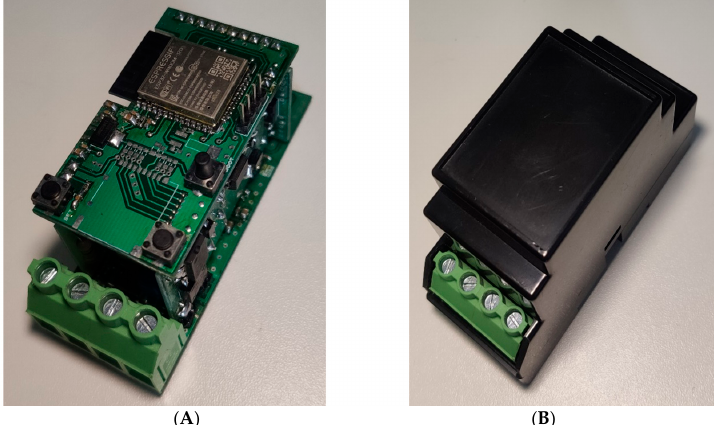
Figure 4. Assembly statement ( A ) of the plates and ( B ) in the DIN box.